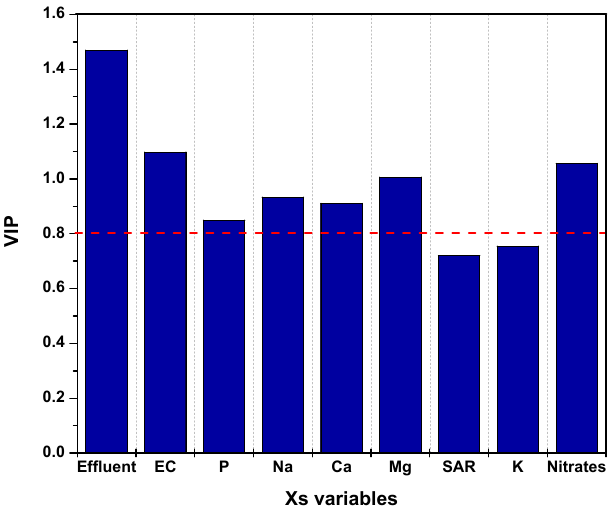
Figure 2. Important X variables in the Partial Least Squares Regression (PLSR) model.